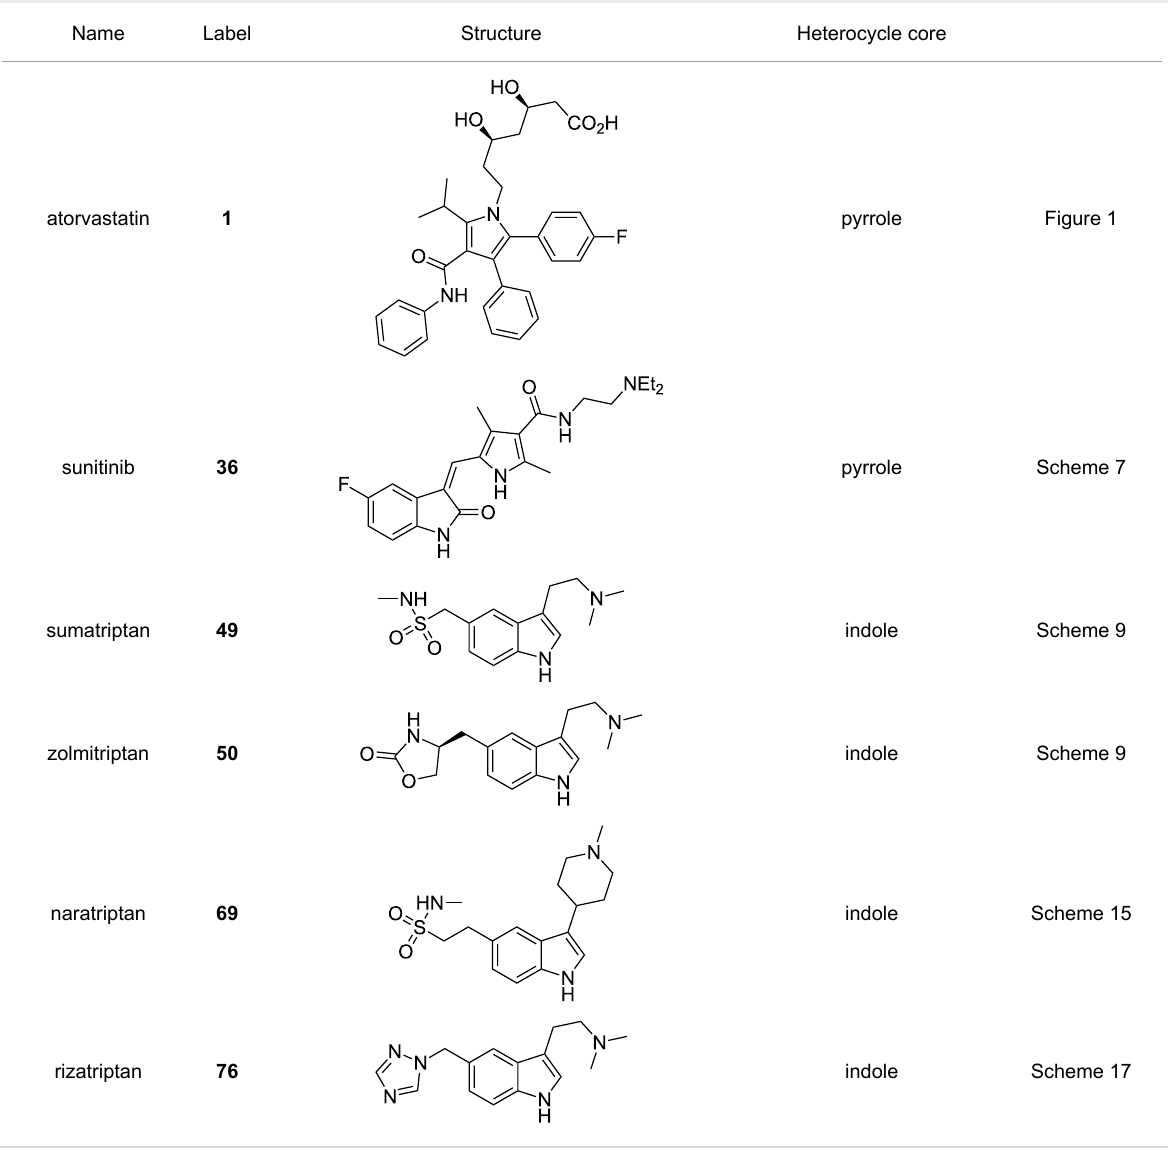
Table 1: Heterocylic structures discussed in this